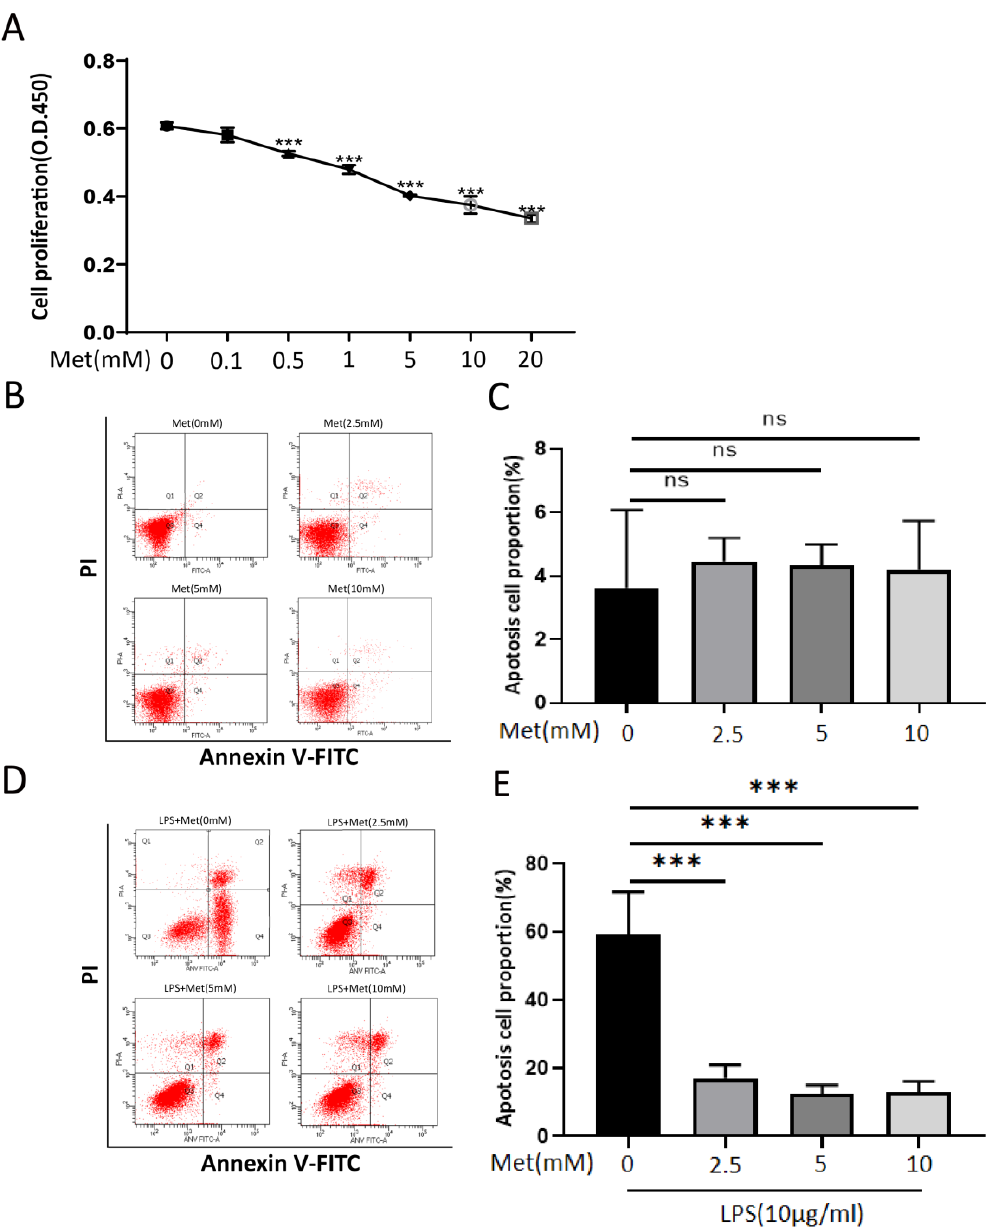
Figure 7. Metformin inhibits the proliferation of RAW 264.7 cells. Metformin protects against apoptosis of RAW 264.7 cells induced by high concentrations of LPS. ( A ) Cell viability was assessed by CCK8 assay. RAW 264.7 cells were treated with different concentrations of metformin (0, 0.1, 0.5, 1, 5, 10, 20 mM) for 24 h. ( B , C ) Effects of metformin at various dose on apoptosis of RAW 264.7 cells. No significant differences were detected by quantification via Annexin V-FITC/PI flow cytometry. ( D , E ) Effects of pretreatment of RAW 264.7 cells with different concentrations of metformin on apoptosis induced by LPS (10 μg/mL). The percentages of apoptotic cells are quantified in the bar graph. All experiments were repeated three times and means ± SDs of the data are presented. ns: no significance, *** p < 0.001. Met (0 mM): NIH 3T3 cells treated without metformin for 24 hMet, Met (2.5 mM): NIH 3T3 cells treated with 2.5 mM metformin for 24 h, Met (5 mM): NIH 3T3 cells treated with 5 mM metformin for 24 h, Met (10 mM): NIH 3T3 cells treated with 10 mM metformin for 24 h, LPS + Met: NIH 3T3 cells treated with metformin for 16 h, then stimulated with the addition of LPS ( 10 μg ) for 8 h.